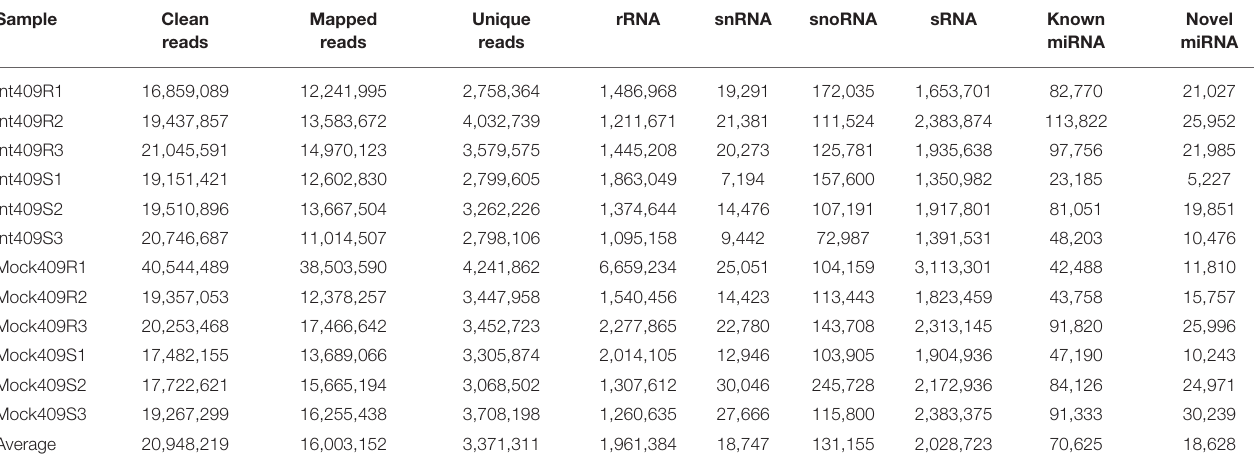
TABLE 1 | Statistics for small ribonucleic acid (sRNA) sequencing data.